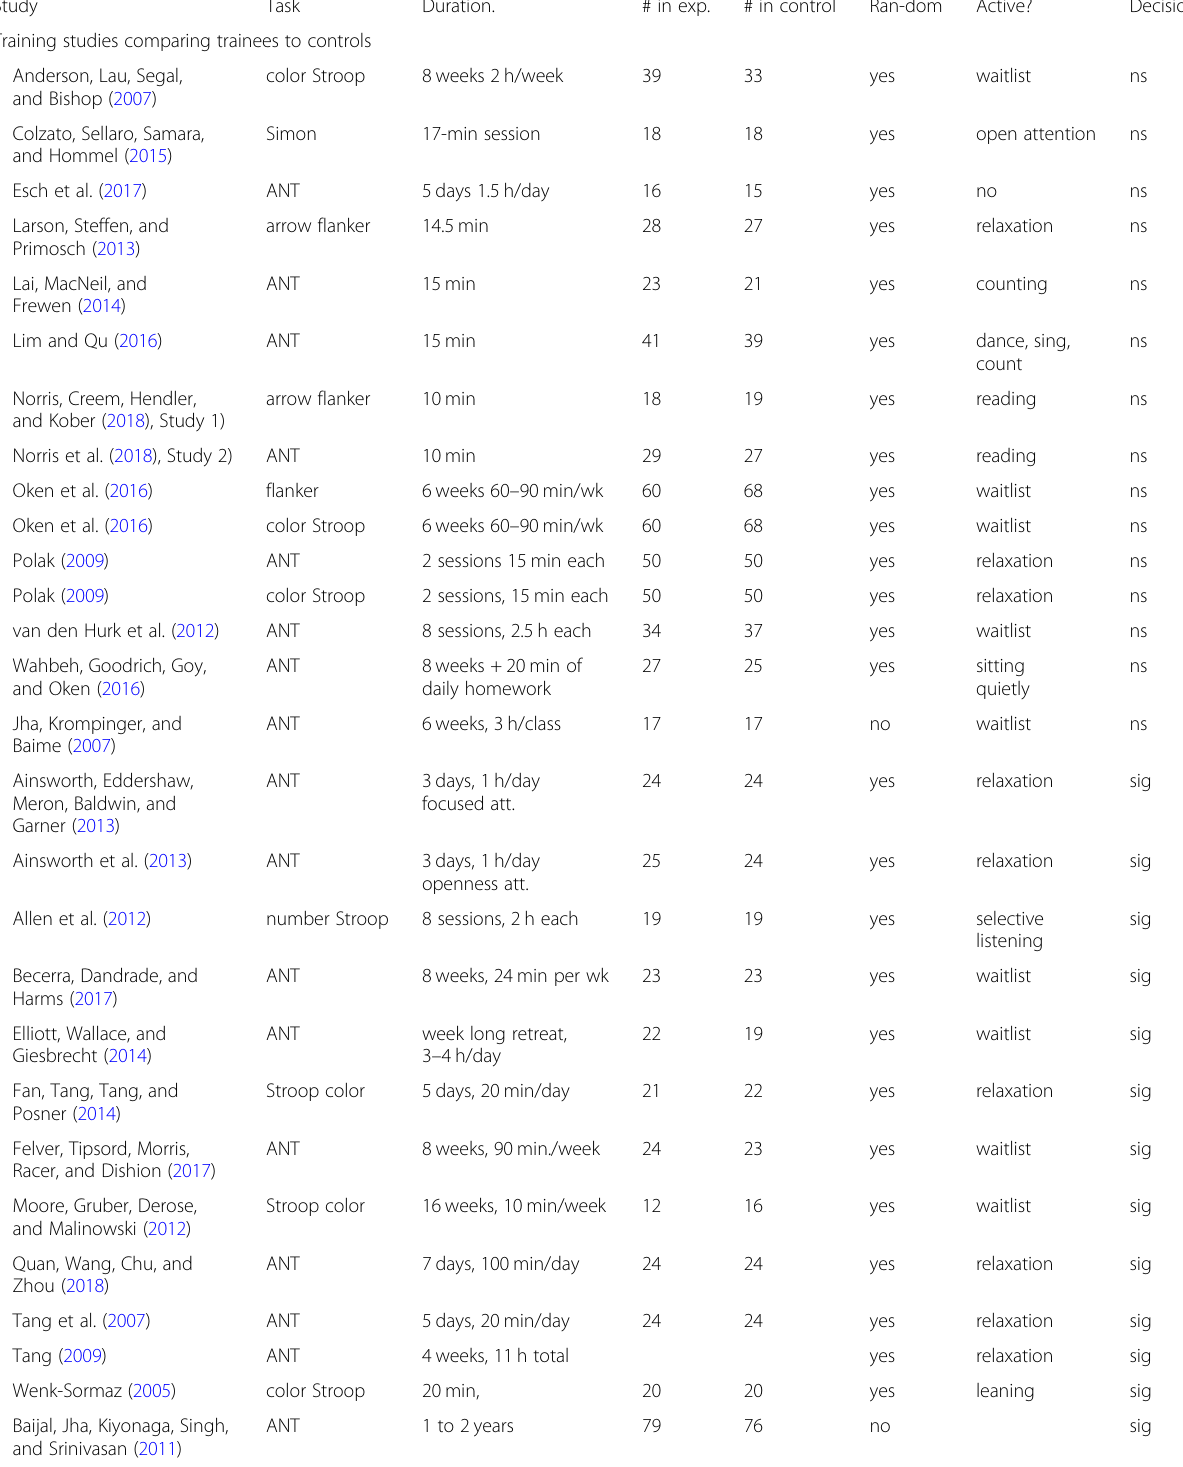
Table 1 Results of studies testing for benefits of mindfulnessmeditation on interference control Study Task Duration. # in exp. # in control Ran-dom